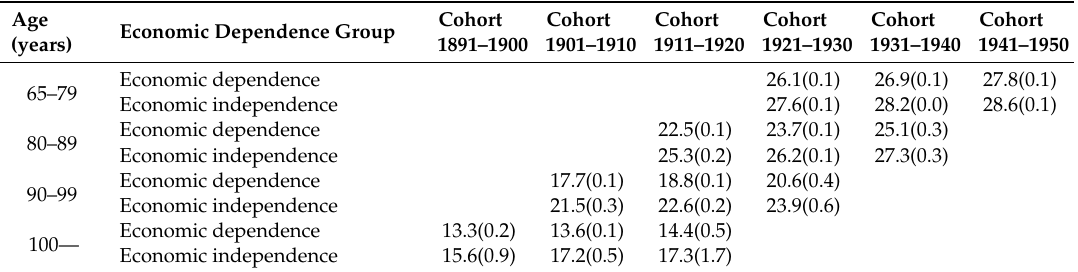
Table 2. The scores of cognitive functions by economic independence or dependence among older adults a